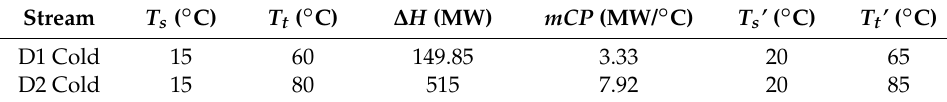
Table 4. Stream data for Industrial Plant D with ∆ T min, pp 10 ◦ C [19].